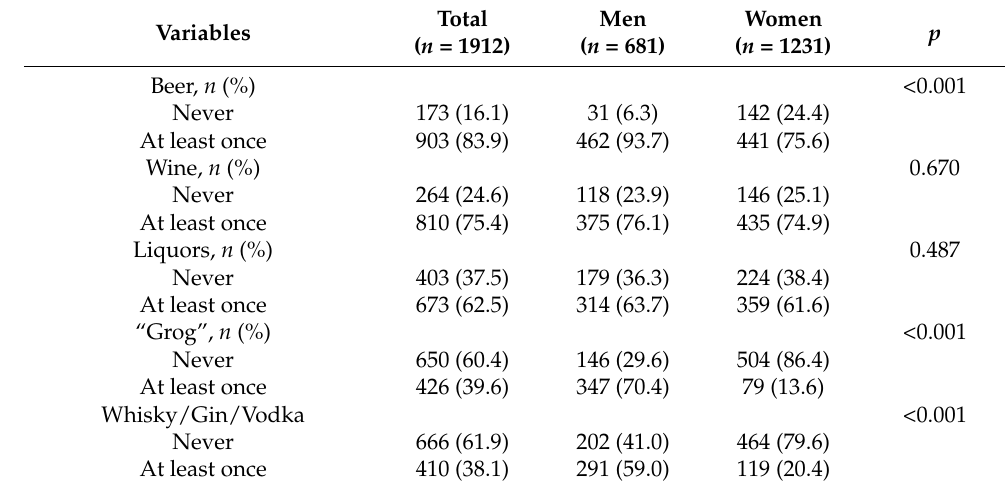
Table A2. Type of alcoholic beverage consumed by gender.